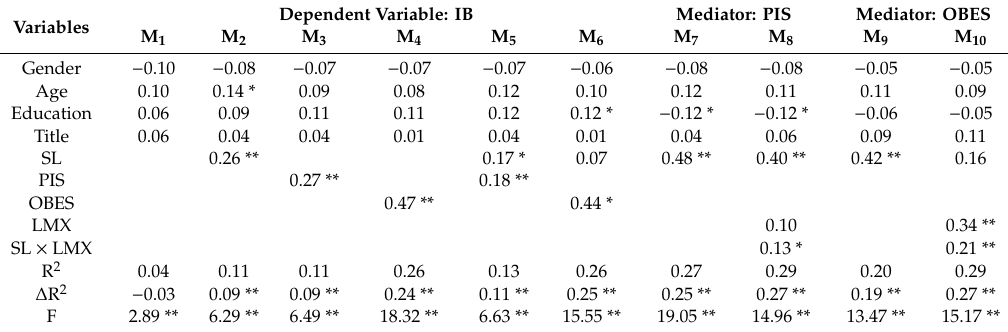
Table 2. Results of hierarchical regression